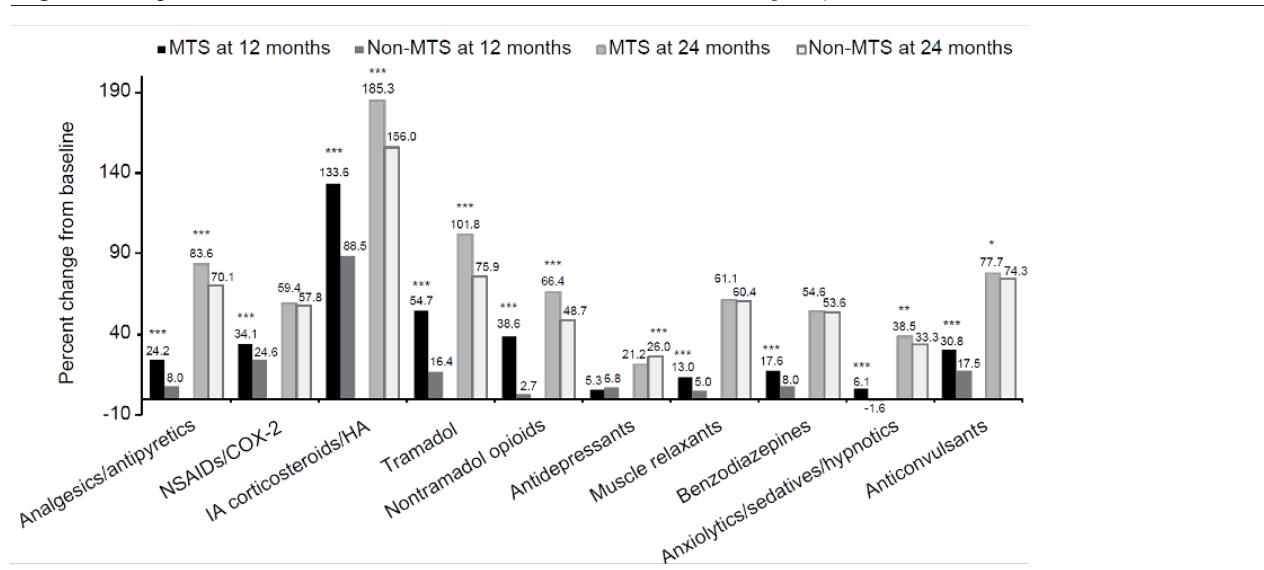
Figure 1. Change in Patients Prescribed Pain Medications at 12 and 24 Months in Propensity Score–Matched Cohorts